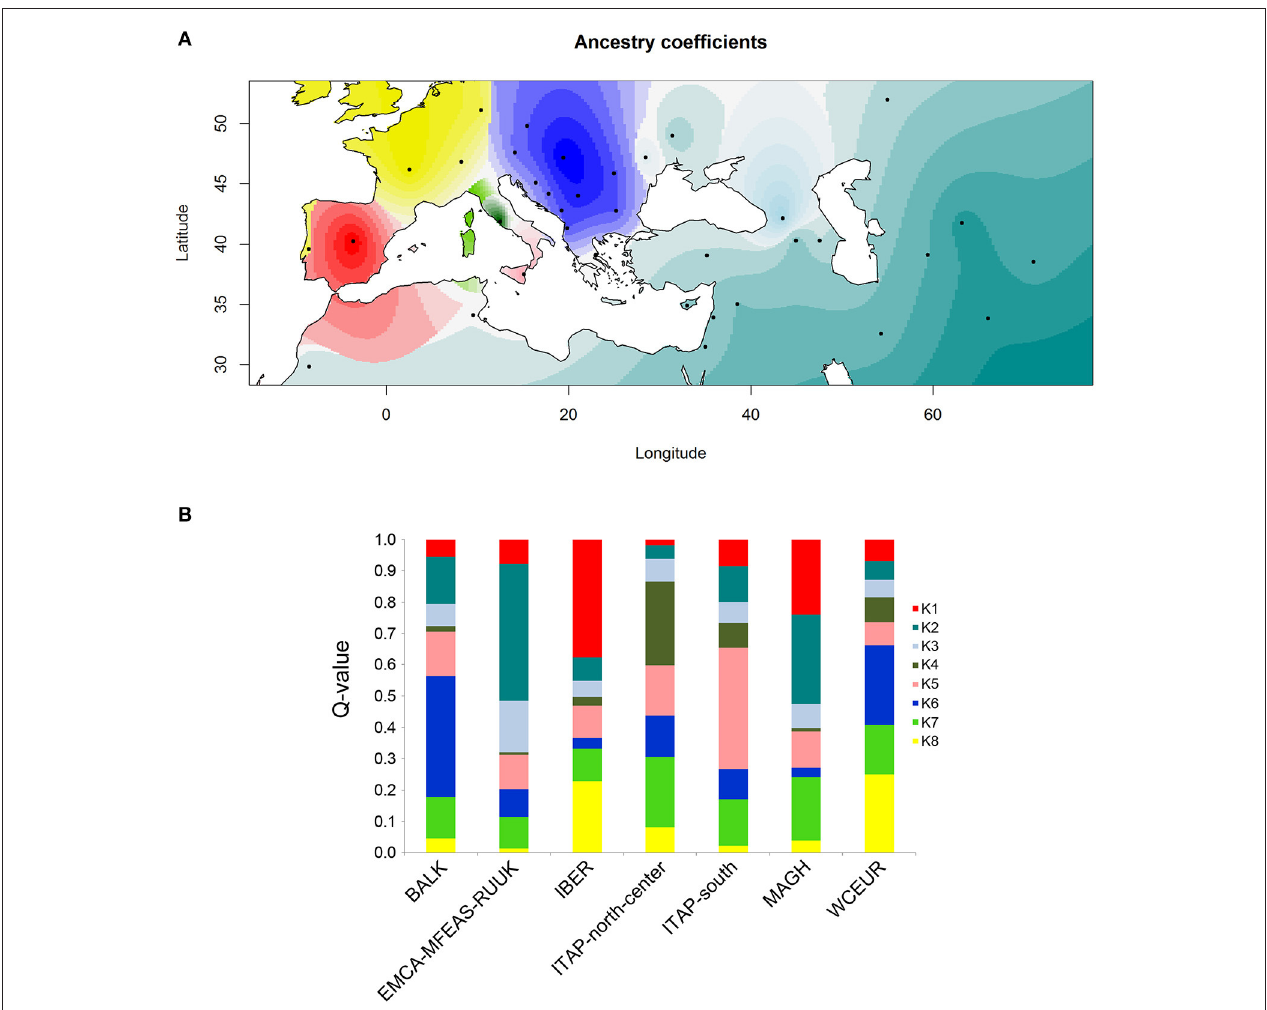
FIGURE 5 | Ancestry coefficient evaluated by R/TESS3 for the whole grapevine germplasm including 21 samples from North Africa (Morocco and Tunisia) named MAGH. The number of ancestral populations ( K = 8) was chosen after the evaluation of a cross-entropy criterion for each K (Supplementary Figure 9) . (A) The values of the Q-matrix ( K = 8) were interpolated on a geographic map, using the centroid for each country studied, except for Russia for a better graphic display. Likewise, the samples from Bosnia and Herzegovina, Croatia, Montenegro, and Serbia were grouped together for a clearer visualization. (B) Bar plot showing the ancestry proportions contributed by K ancestral source populations by calculating the average value of each of the 8 membership coefficients ( Q -value) for each of the seven groups defined by geographic origin (Table 1 and Supplementary Table 1)